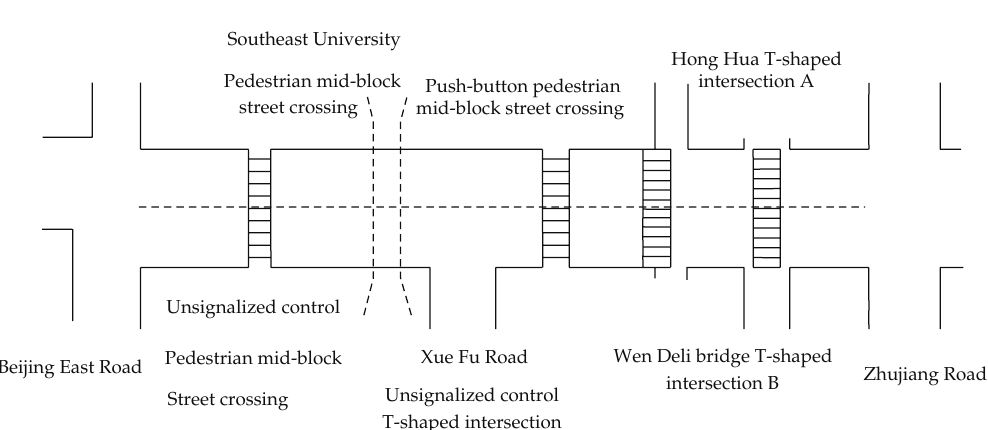
Figure 5: The road layout diagram of Taiping Road (cid:4) Zhujiang-Beijing East Road (cid:5) actuality.